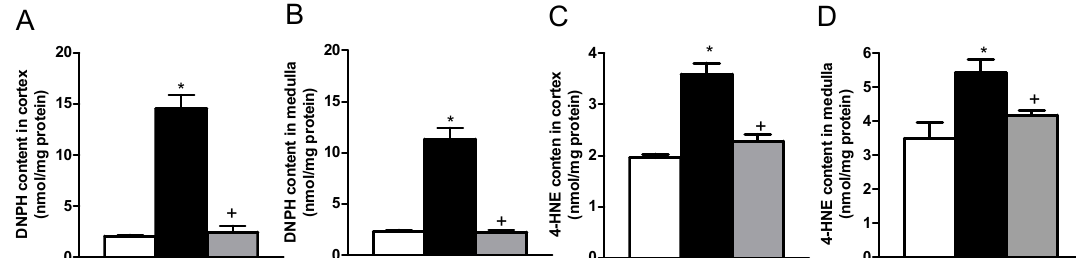
Figure 3. Effects of allicin on oxidative stress markers in kidney; protein oxidation in ( A ) cortex and ( B ) medulla, and lipid oxidation in ( C ) cortex and ( D ) medulla. White bars, black bars and grey bars indicate the control, untreated diabetic and allicin-treated diabetic groups, respectively. Data represent the average of values from all the animals ( n = 6) in a given group ± SEM (* p < 0.05 vs. the control group; + p < 0.05 vs. the diabetic groups).